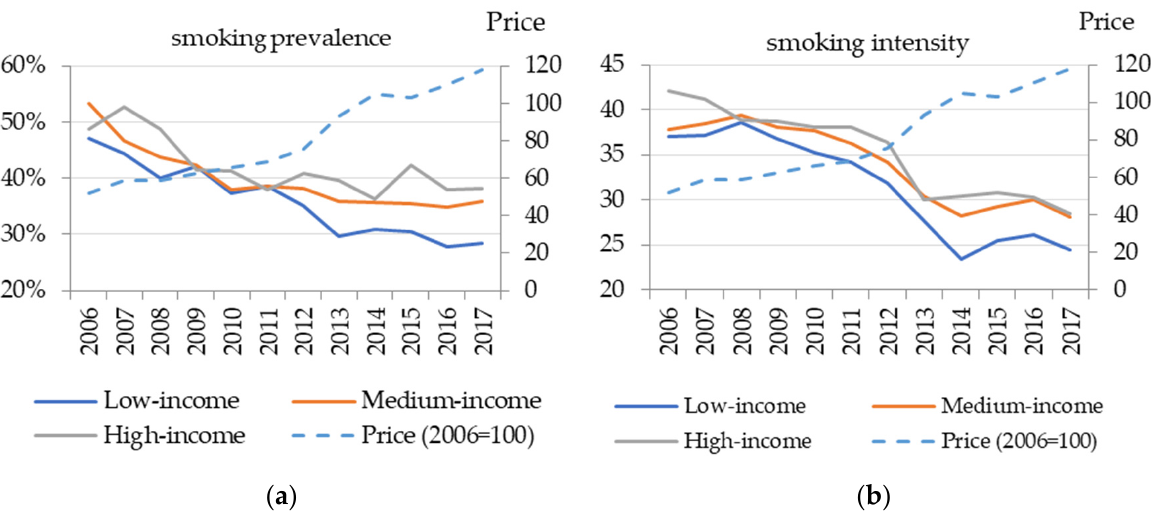
Figure 1. Smoking prevalence ( a ) and conditional (demand) intensity ( b ) trends by income group. Source: Authors’ calculation based on HBS data. Notes: Smoking prevalence is defined as the share of the households with positive tobacco consumption, while smoking intensity represents the number of cigarette packs a household with positive expenditures on cigarettes smoked per month. Cigarette prices are defined as municipality/year average cigarettes’ unit values (ratio between total expenditure and quantity) and are expressed in real terms (2006 = 100). Income groups are constructed based on total household consumption (a proxy for income) per capita.